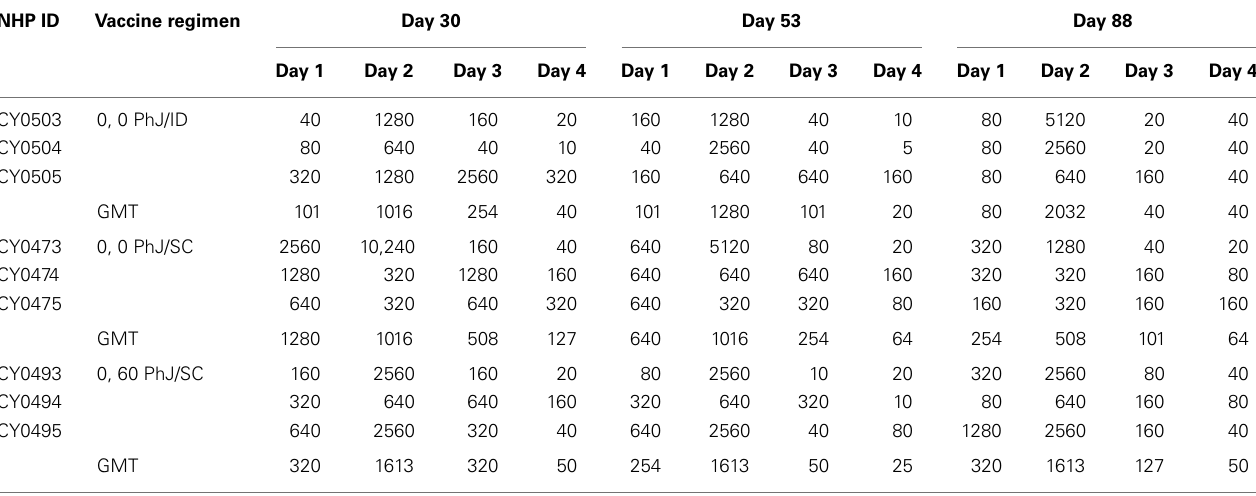
Table 4 | Kinetics of neutralizing antibody responses in animals vaccinated withTDV SC or ID using the PharmaJet device . NHP ID Vaccine